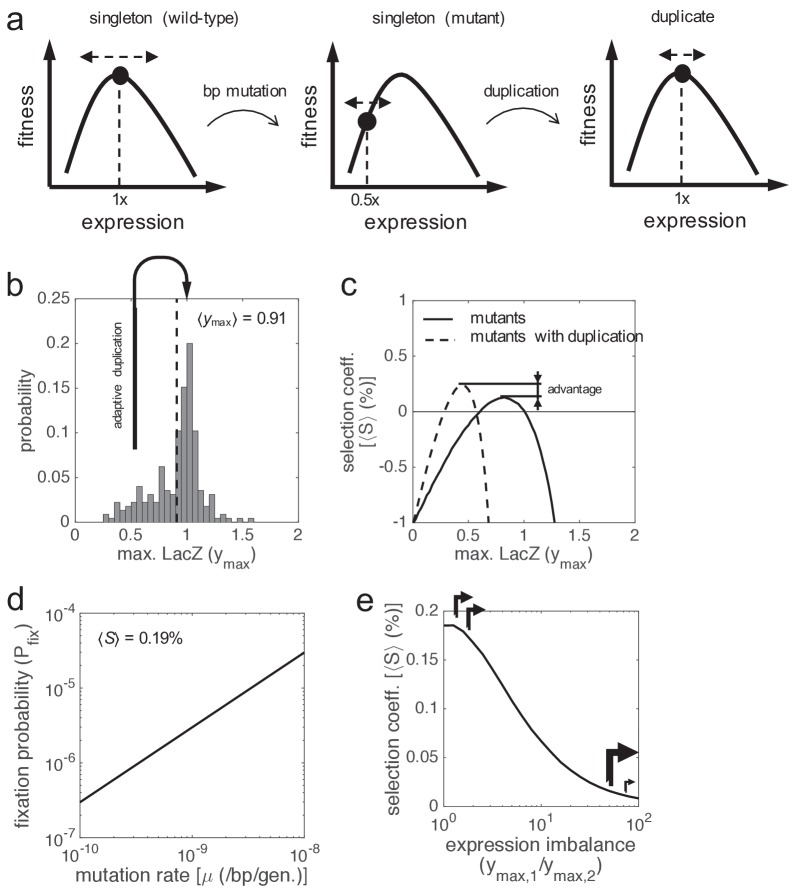
Gene duplication leading to maintained expression. (a) Schematics of fitness as a function of expression showing a path to reach adaptive gene duplications without the need for more expression. Two steps are considered: first a base-pair mutation that reduces in half the expression level, and then a duplication that recovers the ancestral level. (b) Distribution of the activity of lac promoter mutants based on experimental data, as the maximal LacZ expression (ymax, irrespective of lactose dose). The mean activity is shown (dashed line). Skewness coefficient of −0.68. (c) ⟨S⟩ of the promoter mutants versus the wild-type system (solid line), with fluctuating lactose dose and high noise levels. The dashed line corresponds to the comparative between promoter mutants that duplicated the lacZ gene and the wild-type system. (d) Fixation probability (Pfix) of gene duplication as a function of the mutation rate of the cell (μ), with ⟨S⟩ = 0.19% and ⟨N⟩ = 2·108. (e) ⟨S⟩ as a function of the expression imbalance between the two lacZ copies (ymax,1 / ymax,2), when the system recovers its ancestral expression levels (ymax,1 = ymax,2 = 0.5), with constant x = 0.13 mM and high noise levels. Arrows illustrate the corresponding promoter strengths.